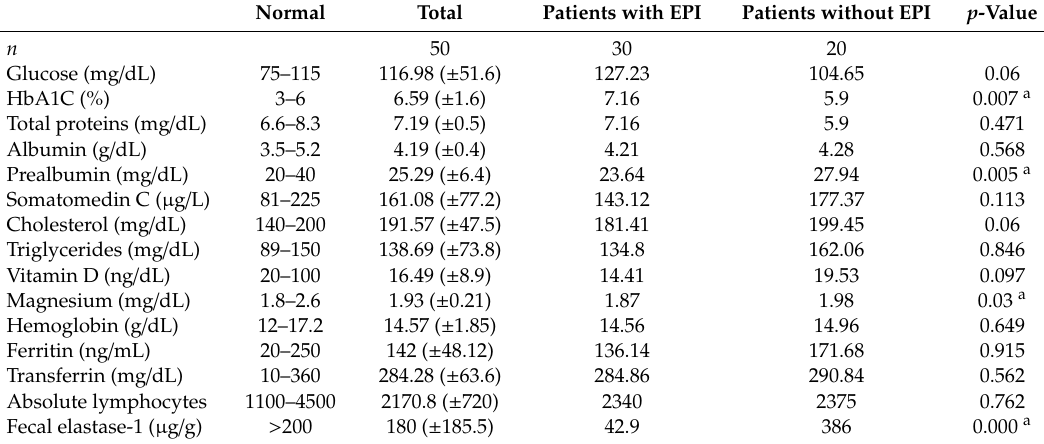
Table 2. Analytical parameters in the study population, group with EPI, and group without